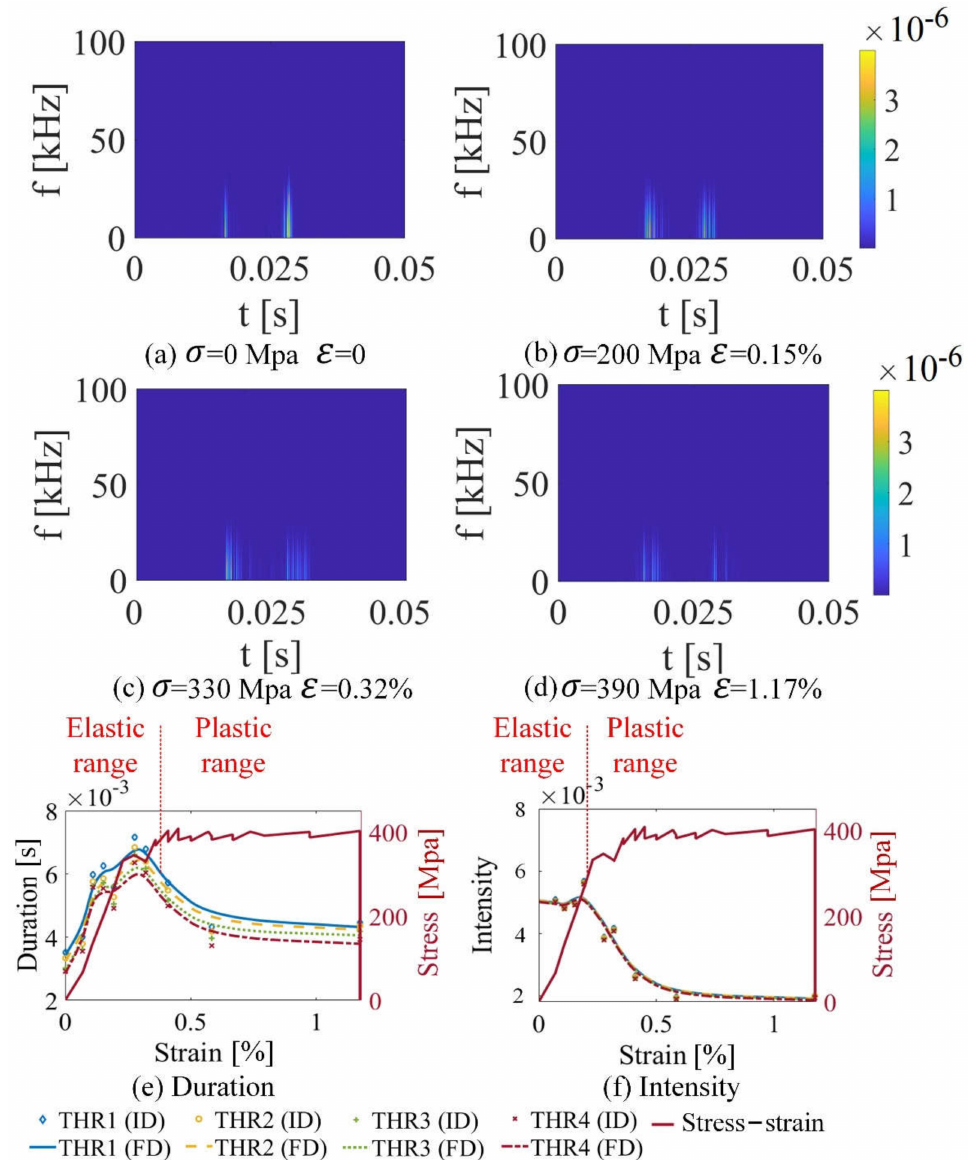
Figure 6. MBN transient eigenvalues ( T σ and INT σ ) on grain S1-g1 with different stress or strain of silicon steel sheet sample 1. ( a – d ) show the time–frequency matrix with different stress or strain; ( e , f ) show T and INT of S1-g1 under stress in elastic and plastic range. THR1, THR2, THR3, and THR4 denote the threshold values; THR1 is equal to 1.1 × 10 − 7 , THR2 is equal to 1.2 × 10 − 7 , THR3 is equal to 1.3 × 10 − 7 , THR4 is equal to 1.4 × 10 − 7 . FD denotes the fitting data, and ID denotes the original